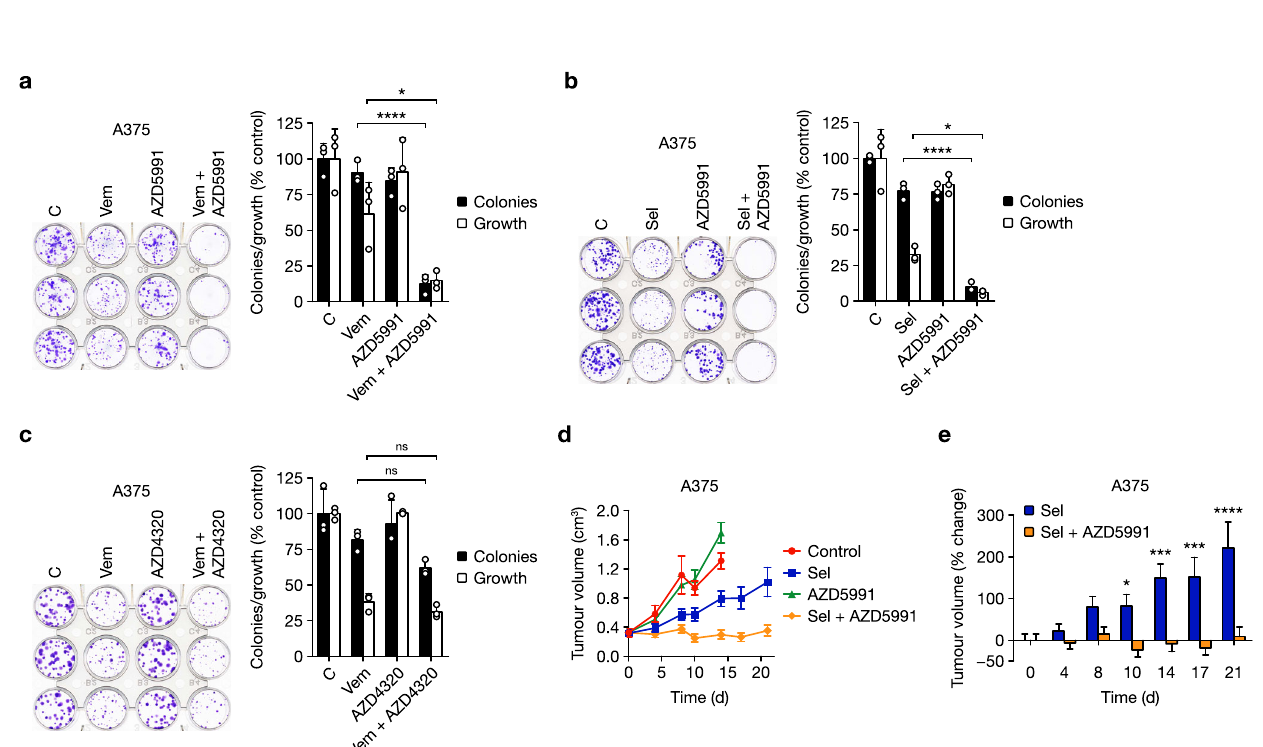
Fig. 3 BRAFi or MEKi combine with AZD5991 to inhibit melanoma cell survival and tumour growth. a A375 cells seeded at low density were treated with DMSO control (C), 2 μ M vemurafenib (Vem), 1 μ M AZD5991 or the combination for 72 h. b A375 cells seeded at low density were treated with